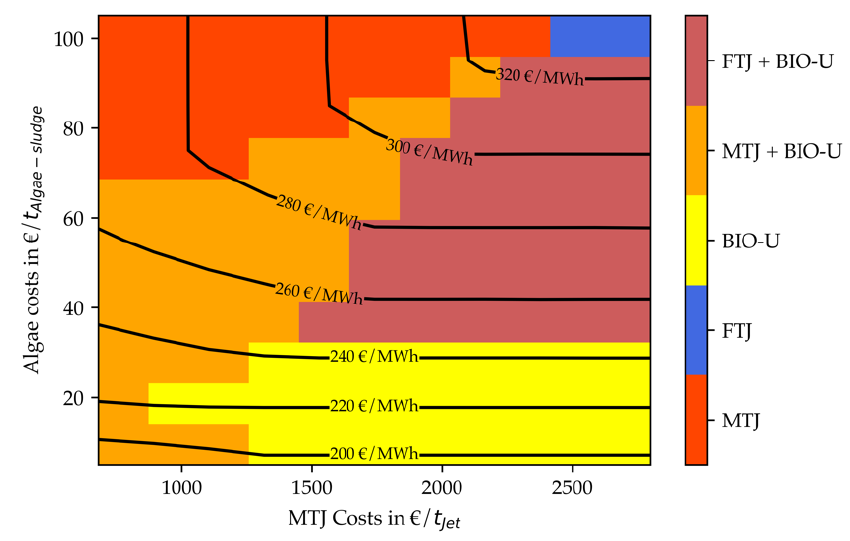
Figure 16. Net production costs (contour lines) and technology choice (heatmap) of optimized renewable refinery depending on algae costs and MTJ costs in scenario 2.